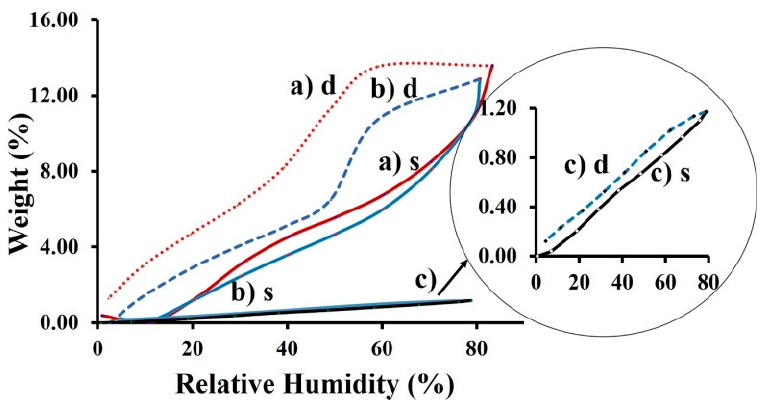
Figure 5. The sorption (s)/desorption (d) isotherms of the nanofibrous mats: (a) C, (b) C-PET, (c) PET. PET is defined as a hydrophobic polyester because it sorbs less than 1% water (g/g dry), as